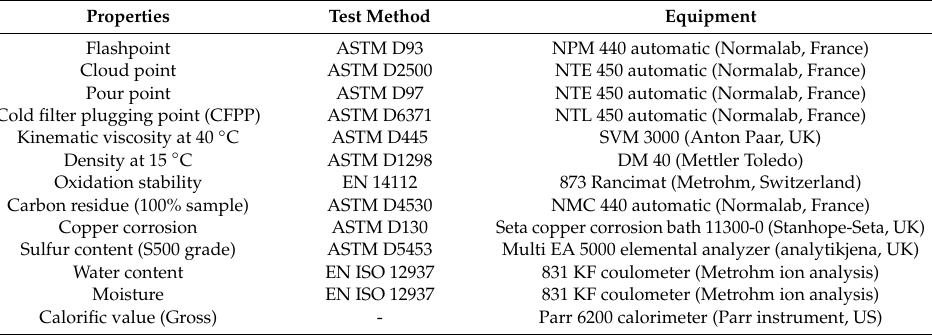
Table 1. Equipment and test methods for biodiesel